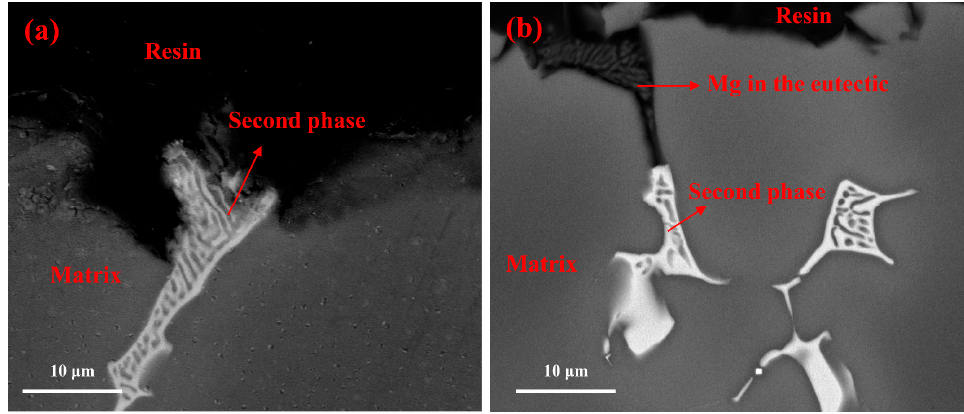
Figure 6. The cross-section morphology of WE43 immersed in NaCl ( a ) and Na 2 SO 4 ( b ) for 10 h.